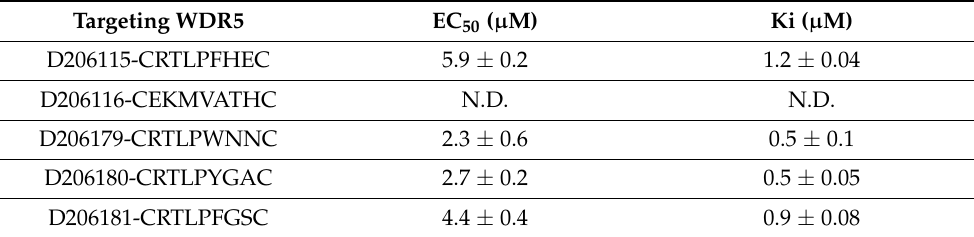
Figure 2. Results derived from FP direct competitive assays of 4 potential cyclic peptides targeting WDR5. Data points represent an average of two independent experiments; error bars are standard deviation. Table 4. Data from direct FP binding experiments; N.D.: not determined; The results are presented as mean ± standard